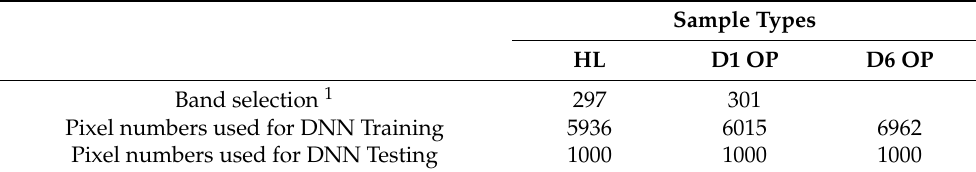
Table 1. Number of pixels used for band section, training, and testing in the rice